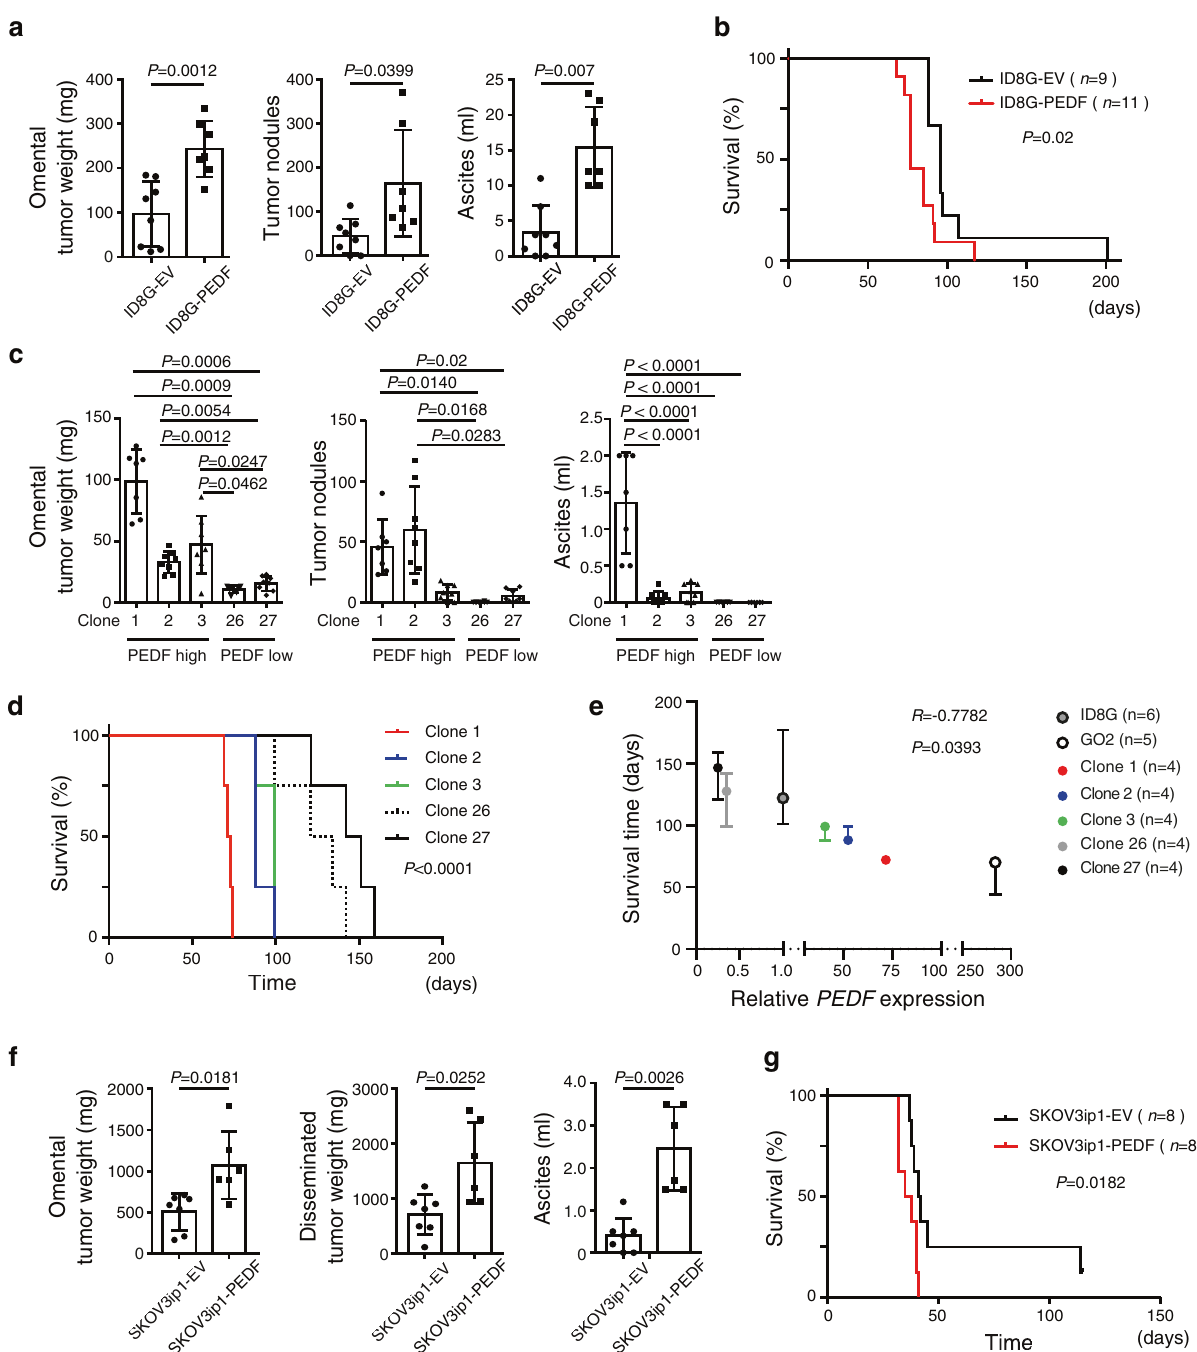
Fig. 2 PEDF expression is associated with increased intraperitoneal dissemination of both mouse and human OC cells and with poor prognosis. a Omental tumor weight, the number of tumor nodules, and the volume of ascites fl uid for C57BL/6J mice at 90 days after injection of ID8G-EV ( n = 8 mice) or ID8G-PEDF ( n = 7 mice) cells into the peritoneal cavity. Data are means ± SD. b Survival curves for mice injected with ID8G-EV ( n = 9) or ID8G- PEDF cells ( n = 11). The P value was determined with the log-rank test. c Omental tumor weight, number of tumor nodules, and the volume of ascites fl uid for C57BL/6 J mice at 63 days after injection of PEDF high or PEDF low clones of ID8G cells into the peritoneal cavity. Data are means ± SD ( n = 7 or 8 mice). Data for omental tumor weight and number of tumor nodules were analyzed by Welch ’ s ANOVA followed by Dunnett ’ s post hoc test and for ascites by Tukey ’ s multiple comparisons test. d Survival curves for mice injected with PEDF high or PEDF low clones of ID8G cells ( n = 4 each). The P value was determined with the log-rank test. e Pearson ’ s correlation analysis for expression of PEDF mRNA versus survival time of mice inoculated with the corresponding cells. Data are median± 95% CI. f Omental and intraperitoneal disseminated tumor weight as well as the volume of ascites fl uid in nude mice at 27 days after injection SKOV3ip1-EV cells ( n = 7 mice) or SKOV3ip1-PEDF cells ( n = 6 mice) into the peritoneal cavity. Data are means ± SD. g Survival curves for mice injected with SKOV3ip1-EV or SKOV3ip1-PEDF cells ( n = 8 each). The P value was determined with the log-rank test. Data for a and f were analyzed by unpaired t test with Welch ’ s